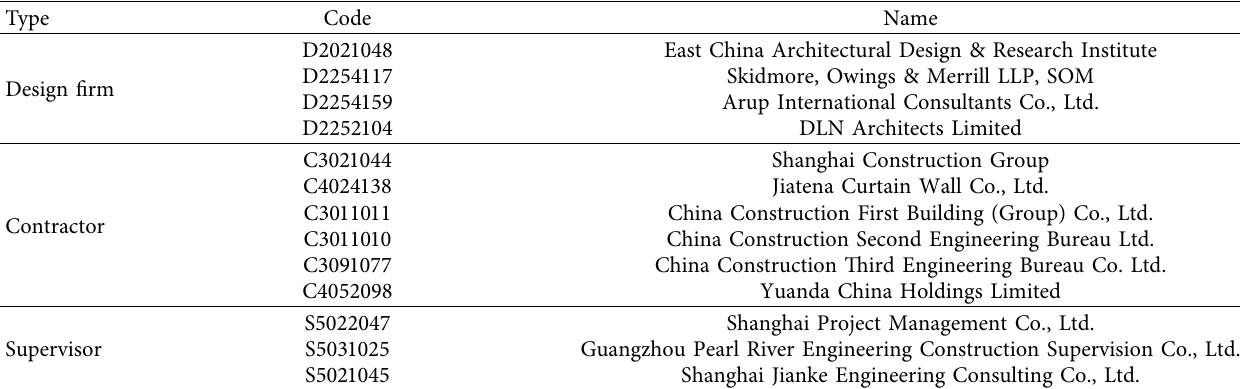
Table 7: The company names of the organizations in Table 6.